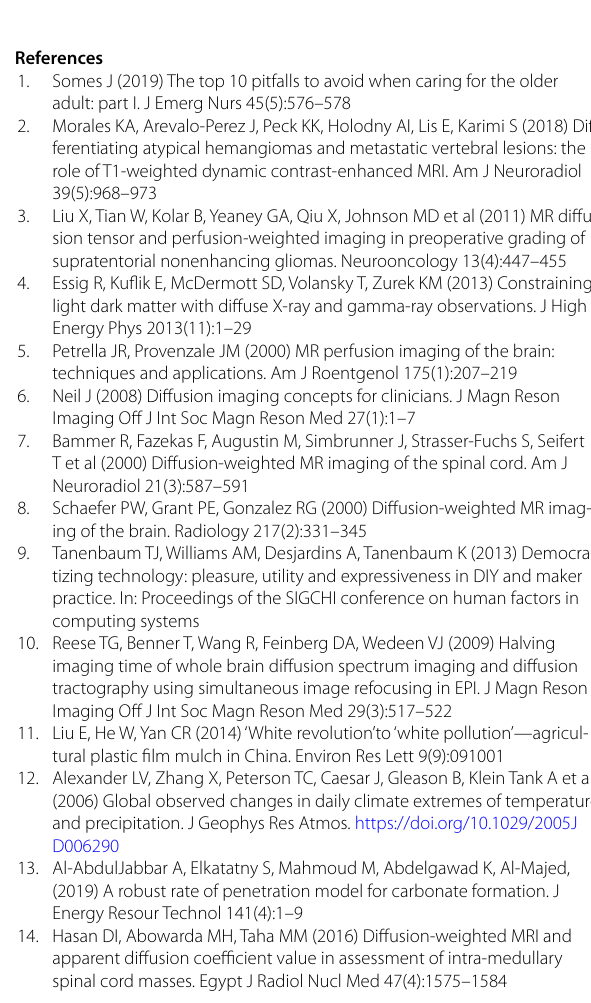
*indicates statistically significant